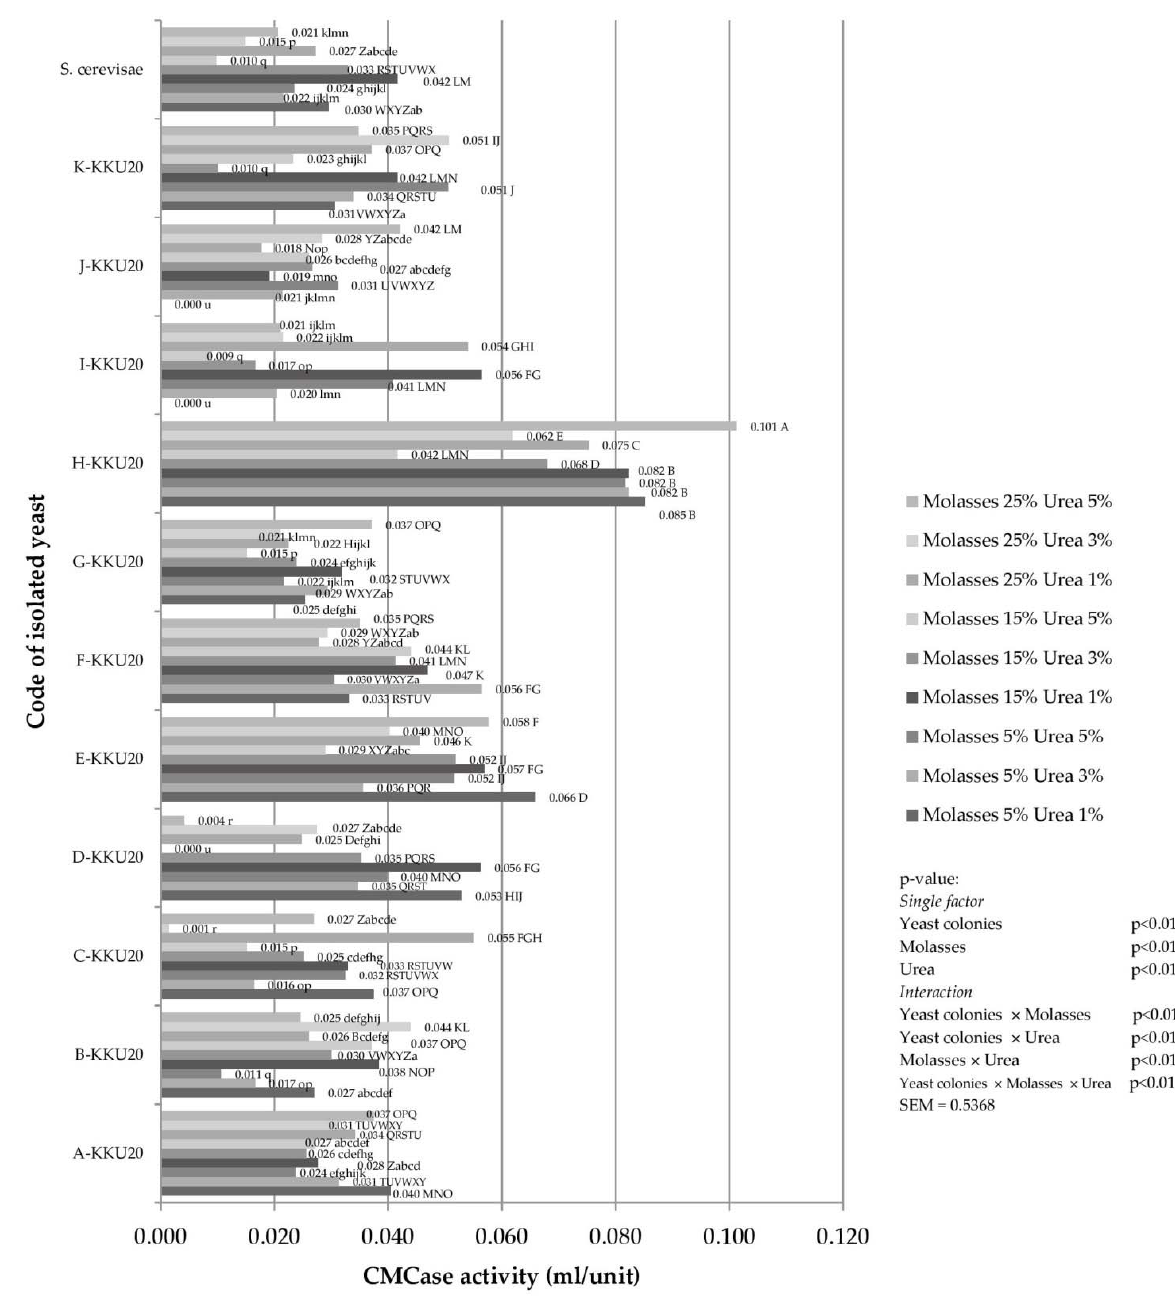
Figure 2. Effect of CMC concentration from 1% ( w / v ) on cellulase production of each rumen fluids isolates yeast at 72 h. A–Z,a–u Means with different superscript letters within a bar chart are considered statistically significant ( p < 0.01), SEM = standard error of the mean, S. cerevisiae = Saccharomyce cerevisiae.